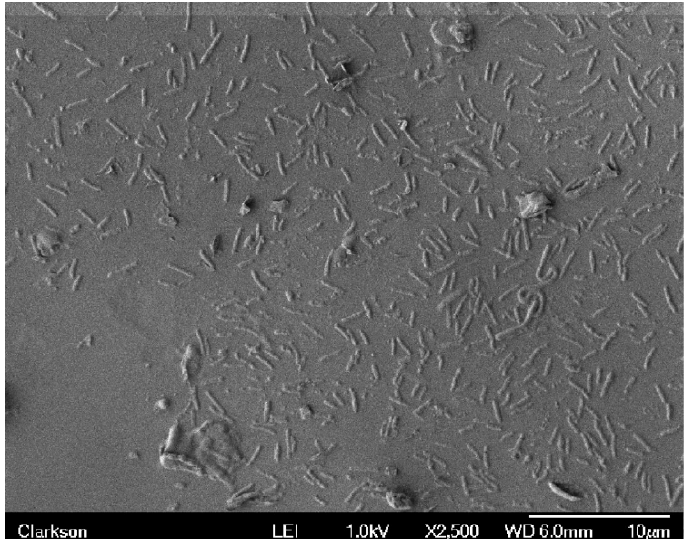
Figure 3. The SEM image (at 2500×) of the aged control latex sample displays many rod shaped